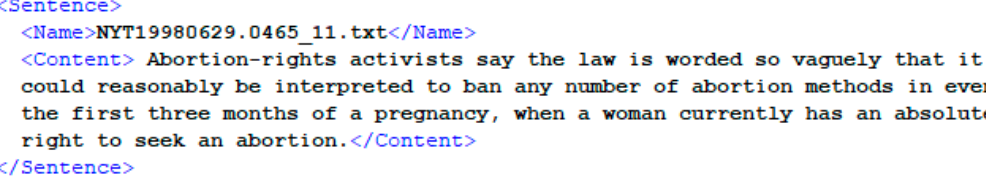
Figure 2. Example of the sentence part within the document from TREC 2003 novelty track.